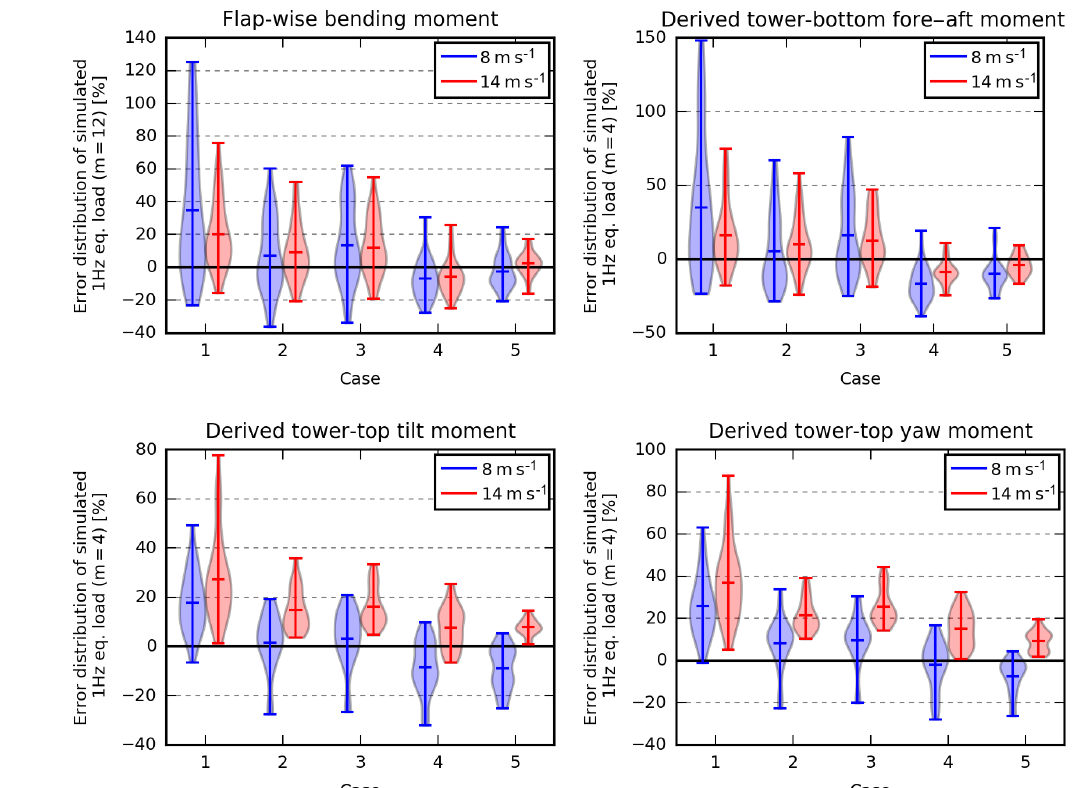
Figure 12. Error distribution of the simulated equivalent